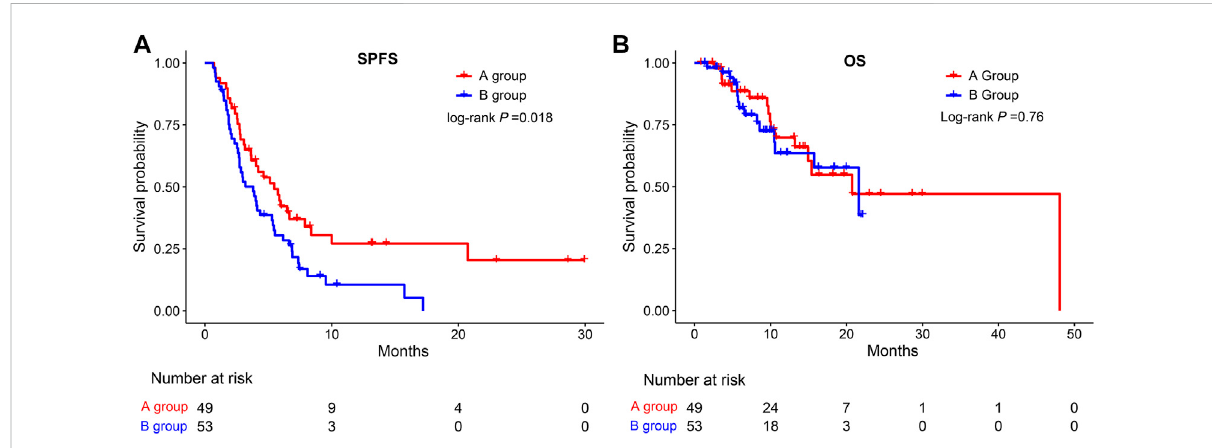
FIGURE 2 Kaplan-Meier survival curves for SPFS (A) and OS (B) of patients in the A group and the B group. SPFS, second progression-free survival; OS, overall survival.